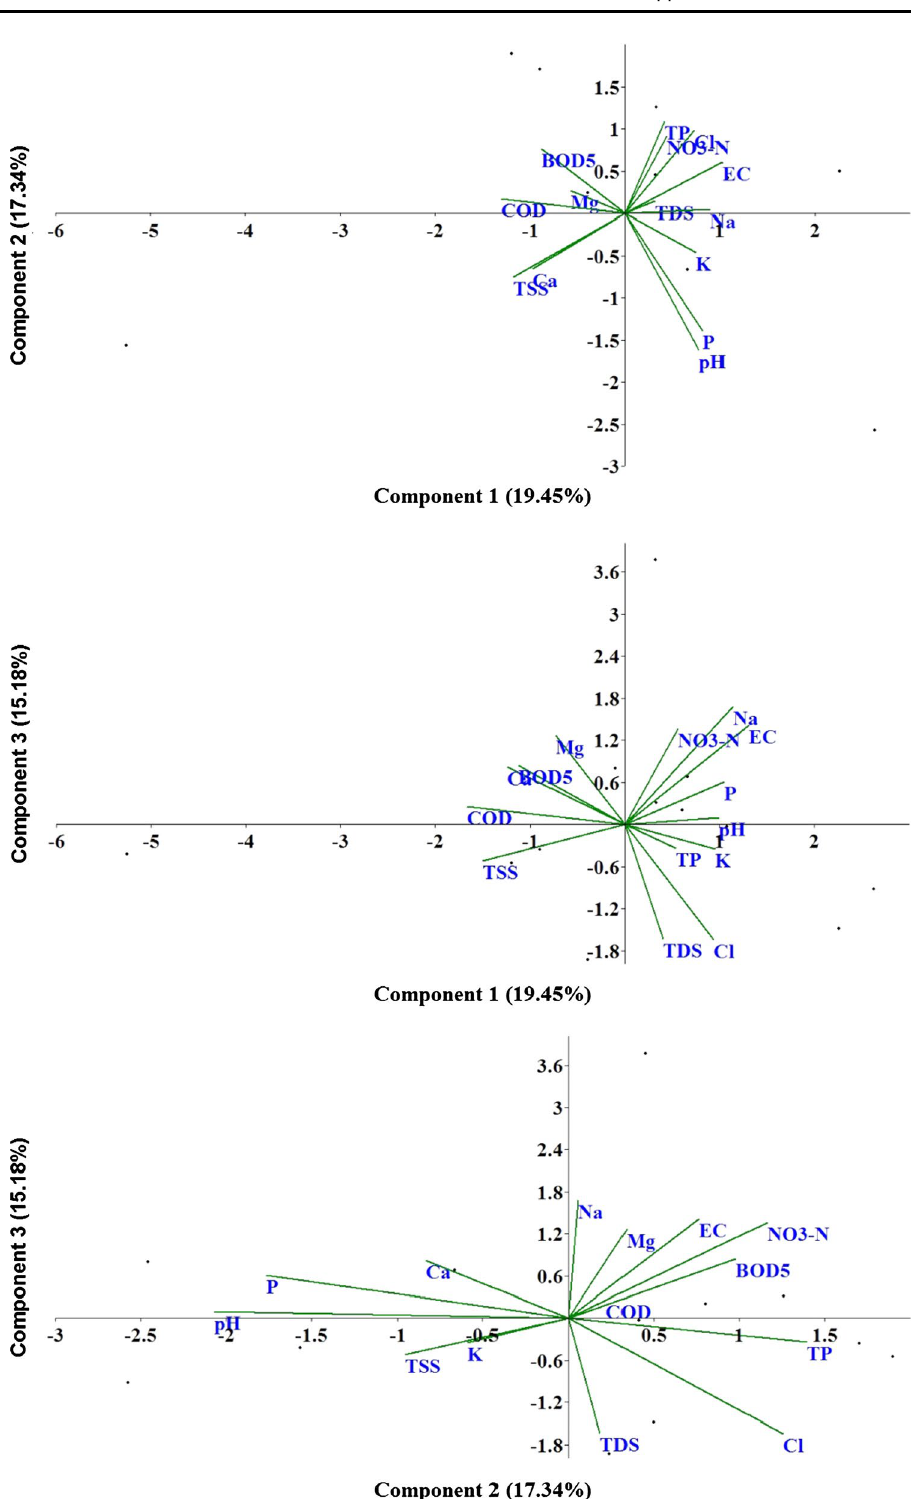
Fig. 2 Biplots for principal component analysis 1 + 2, 1 + 3 and 2 + 3 component of